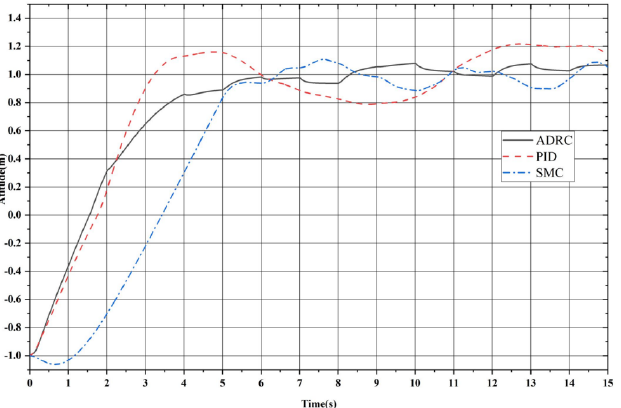
Figure 7. Comparison of simulation results of PID, SMC, and ADRC outgoing water motion height control.